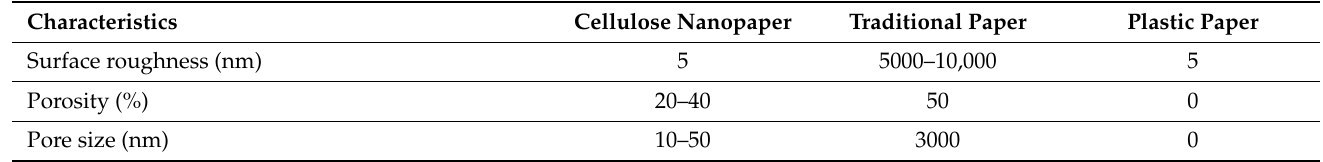
Table 2. Comparison of cellulose nanopaper, traditional paper, and plastic.